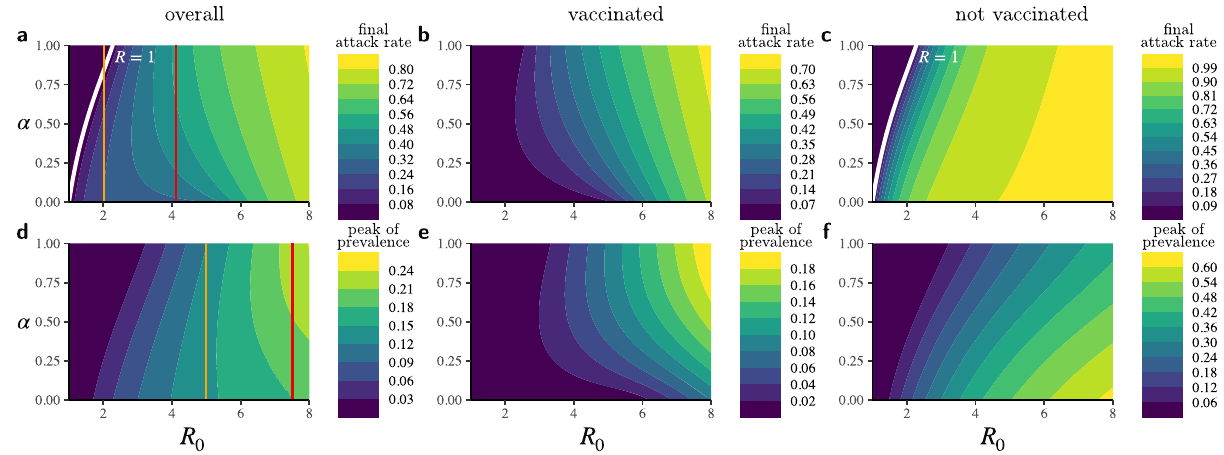
Fig. 3 The three dynamical regimes as predicted by the mean fi eld model. Final attack rate a – c and peak of prevalence d – f as functions of the basic reproduction number, R 0 , and the mixing parameter, α , as resulting from the numerical iteration of the differential equations governing the system dynamics (Eqs. (6) – (9)). Here, the vaccine coverage is V = 0.7 and the vaccine ef fi cacy ε = 0.8. In order to highlight the competing processes at the base of the dynamics we show, besides the results for the population overall ( a , d ), those for the vaccinated individuals ( b , e ) and for the not vaccinated ones ( c , f ), separately. The white solid line indicates the critical curve, α c ≡ α c ( R 0 ), at which R = 1, as computed from Eq. (12). The orange and red vertical lines, demarcate the boundaries between, respectively, the critical and the intermediate regime, and the intermediate and the saturated one, for both the fi nal attack rate ( a ) and the peak of prevalence ( d ).